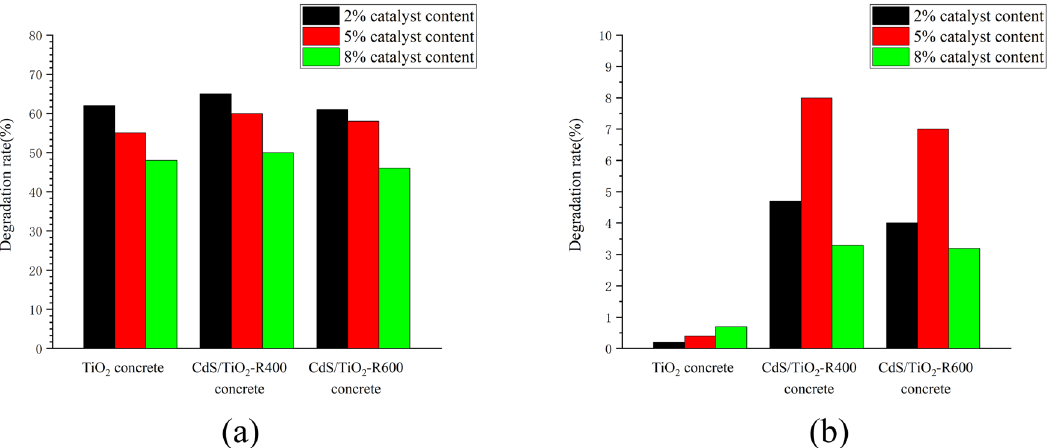
Figure 6: Photocatalytic e ffi ciency of photocatalytic concrete with di ff erent catalyst contents. ( a ) Ultraviolet light, ( b ) visible